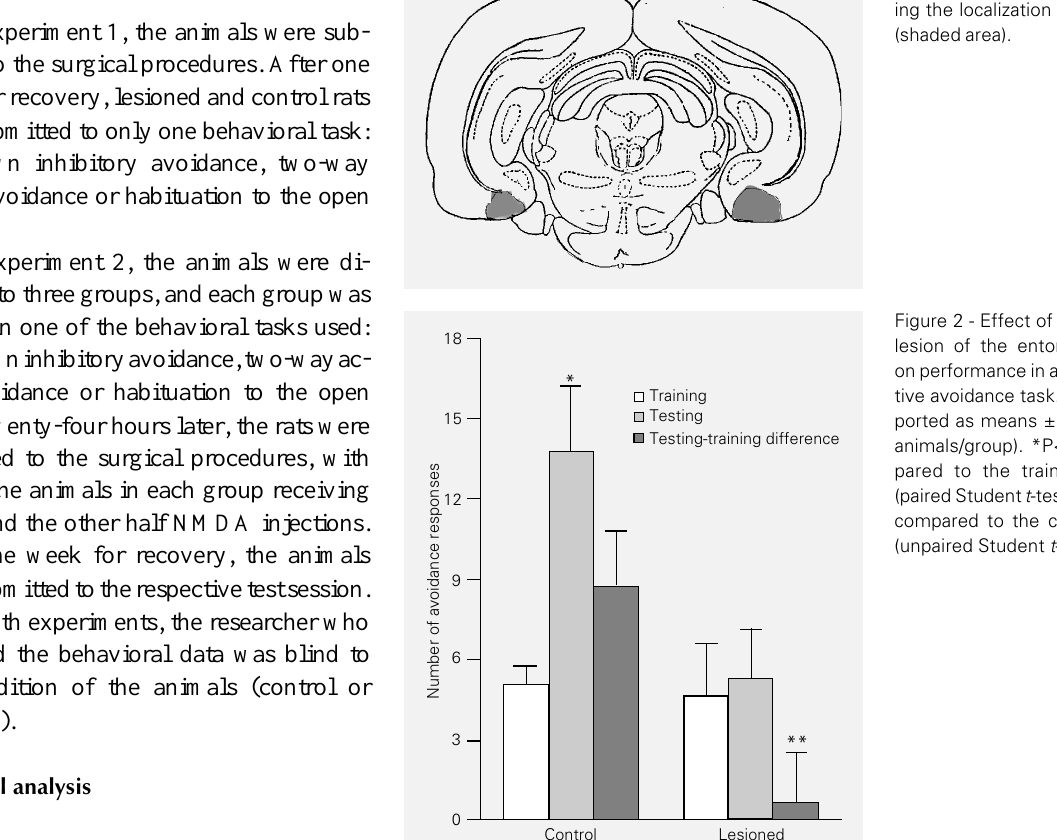
Figure 1 - Drawing of a repre- sentative coronal section show- ing the localization of the lesion (shaded area).